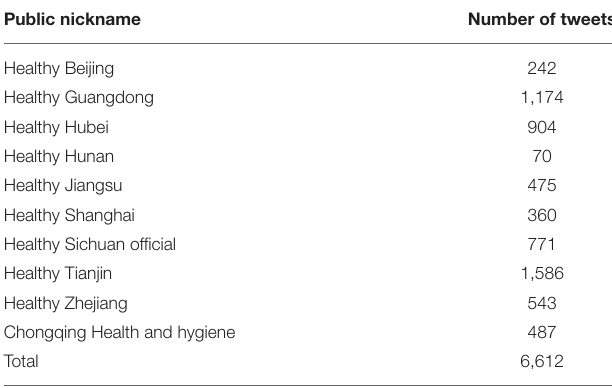
TABLE 1 | Number of public media tweets from the Government Health and Wellness Committee.